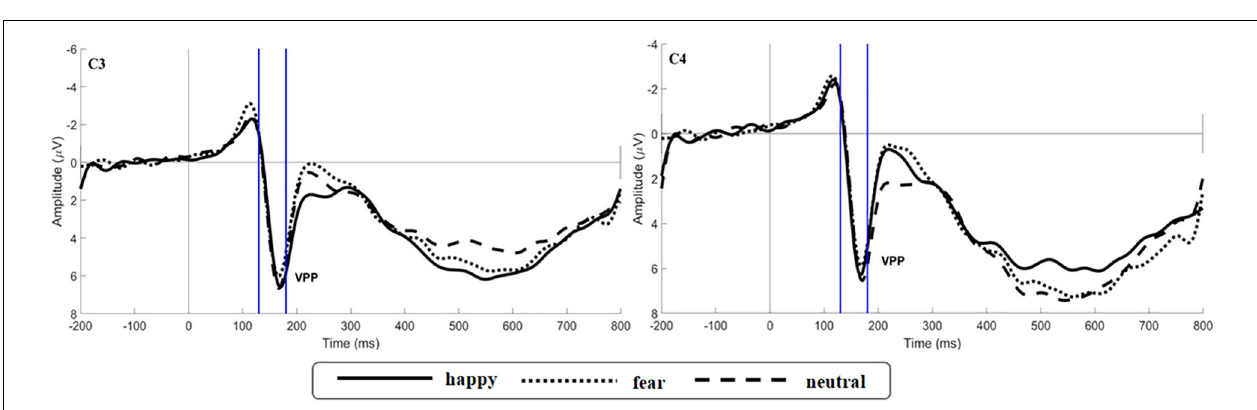
Frontiers in Neuroscience |